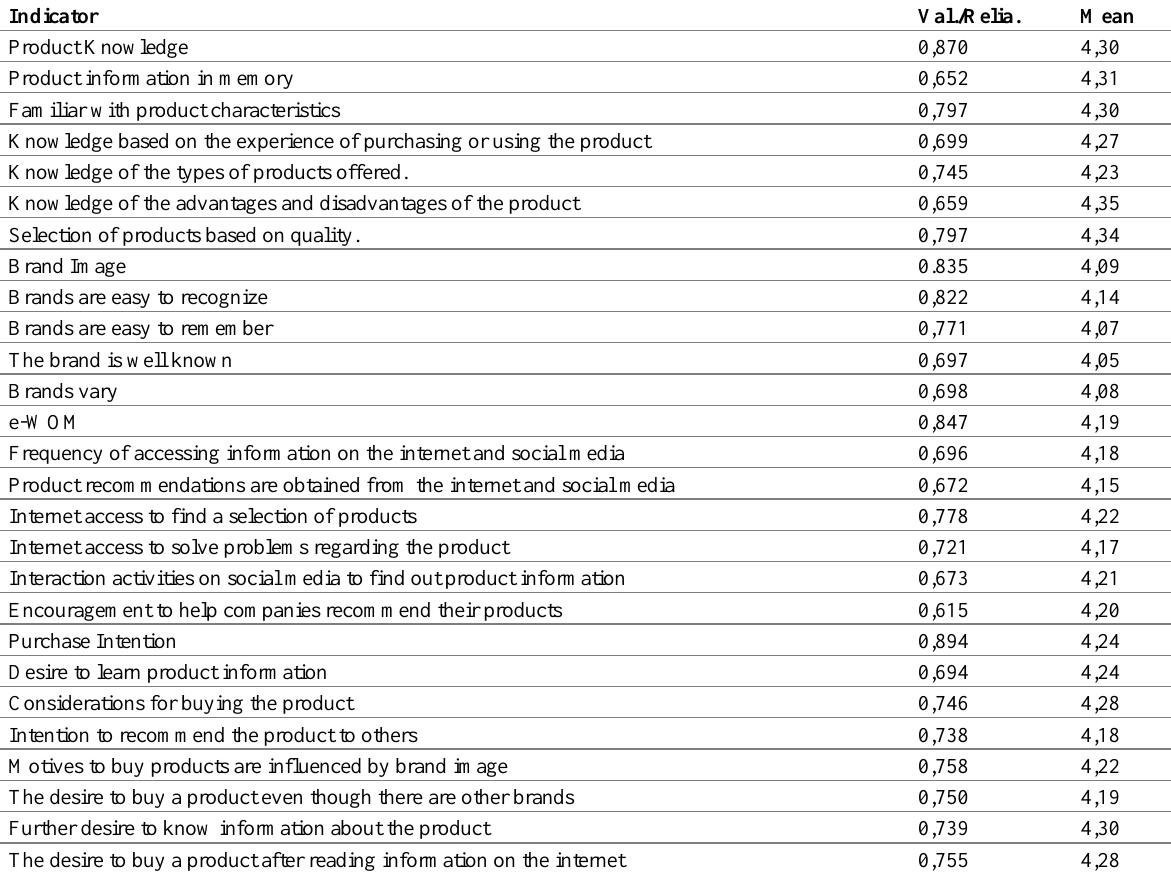
Table 1: Validity Test, Reliability and